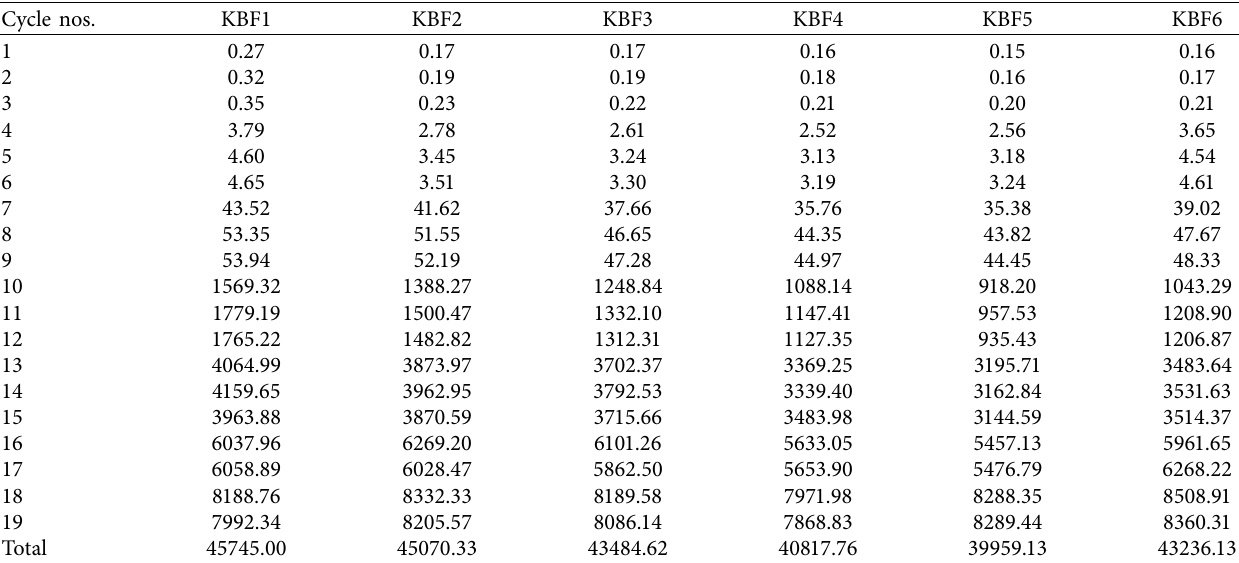
Table 3: Te amount of dissipated energy in cyclic loading (kN). Cycle